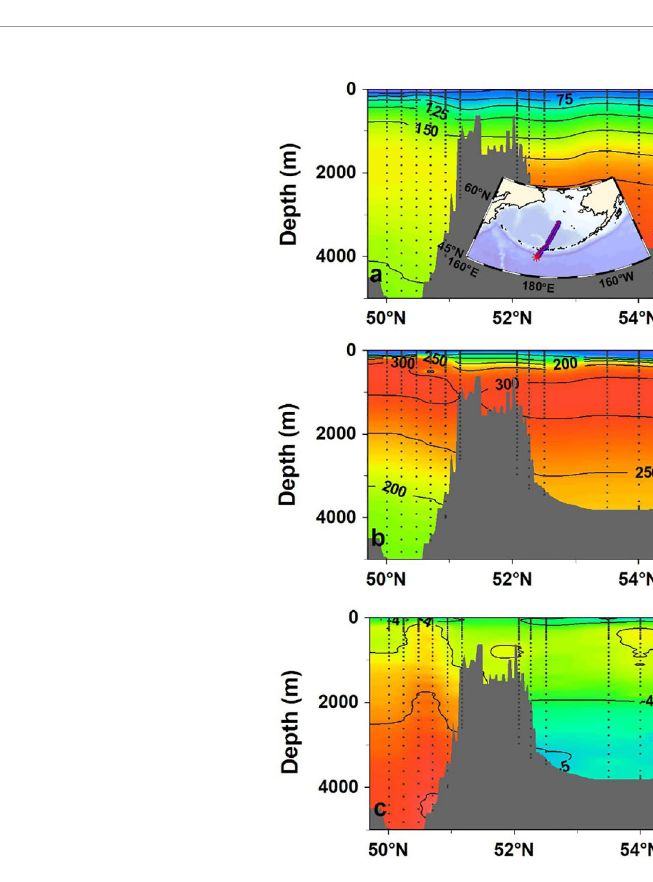
FIGURE 4 | Cross-sectional distribution of (A) DSi ( m mol/kg), (B) apparent oxygen utilization (AOU; m mol/kg), and (C) N* ( m mol/kg) in the North Paci fi c Ocean and Bering Sea. The nutrient tracer N* represents the net effect of nitrogen fi xation and denitri fi